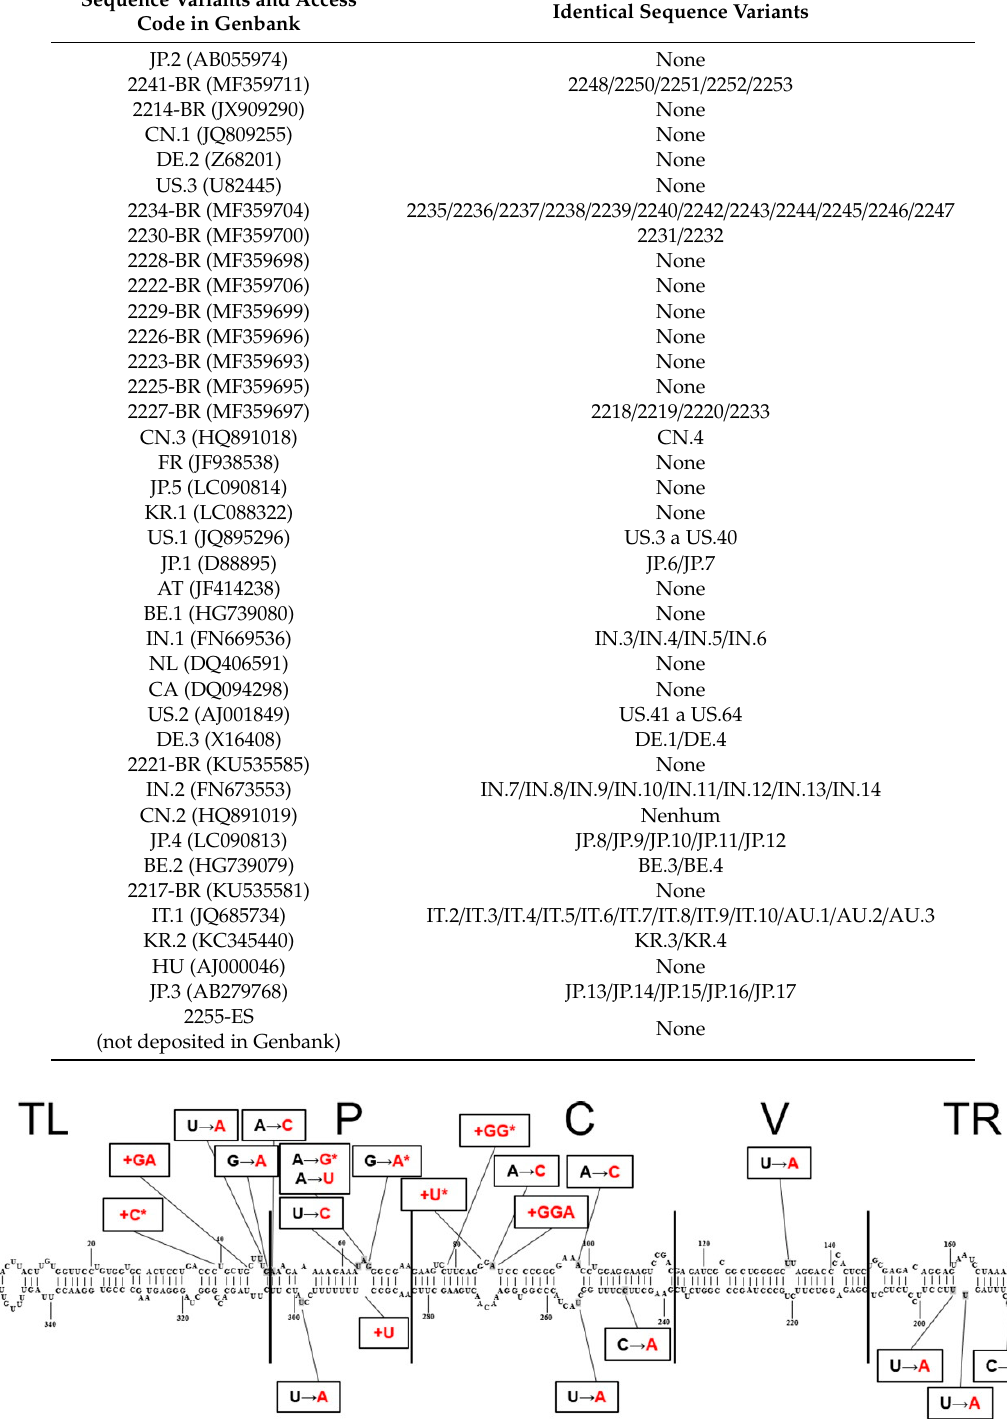
Table 3. Sequence variants of chrysanthemum stunt viroid (CSVd) with identical nucleotide sequences to the variants deposited in Genbank.